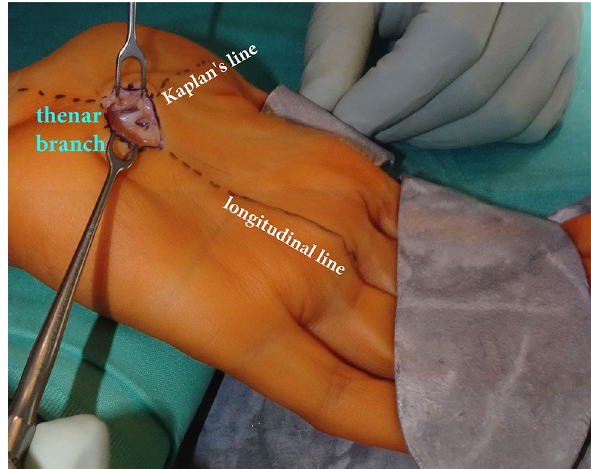
Figure 4. Intraoperative picture of MCTR: The exit point of the thenar branch of the median nerve is fully visible in the surgical field. The superficial palmar artery arch is protected and visible through the skin incision and the proximal direction of the split. {MEDICON eG, Art.-No. 20.50.05, Germany}. MCTR mini-open carpal tunnel release.